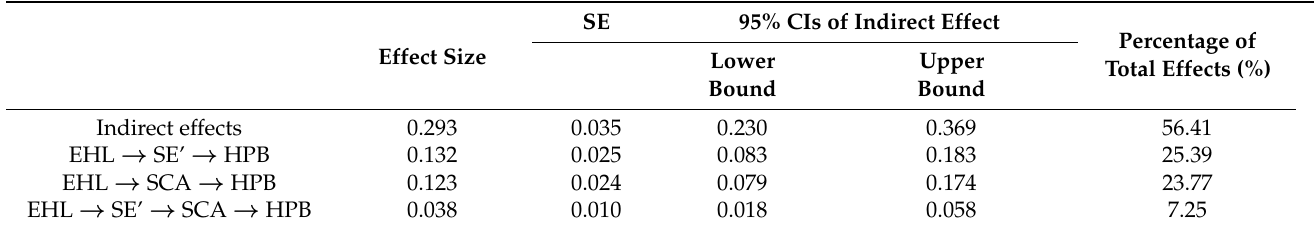
Table 4. Bootstrap analysis of multiple mediation